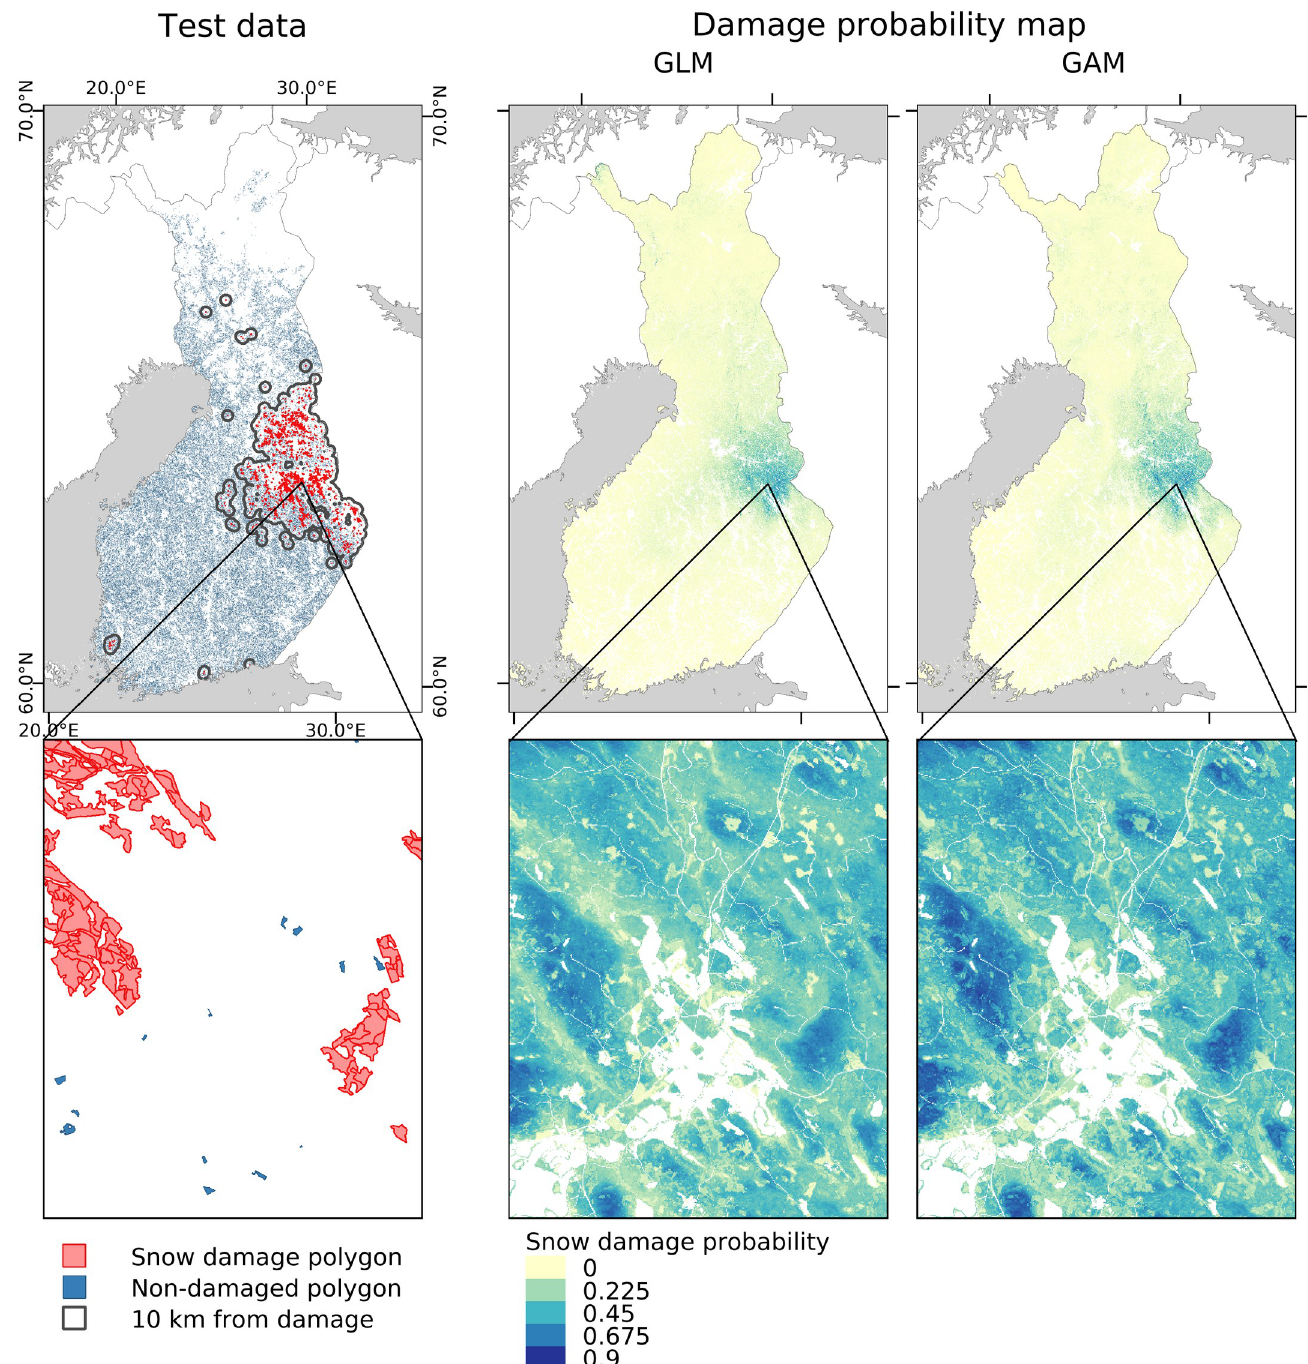
Fig 6. The Forest Centre data (published under CC BY 4.0 licence) used for testing the snow damage probability maps, and the snow damage probability maps calculated with the snow load data from winter 2017–2018, using the full GLM and GAM models. Background map: Natural Earth (public domain).